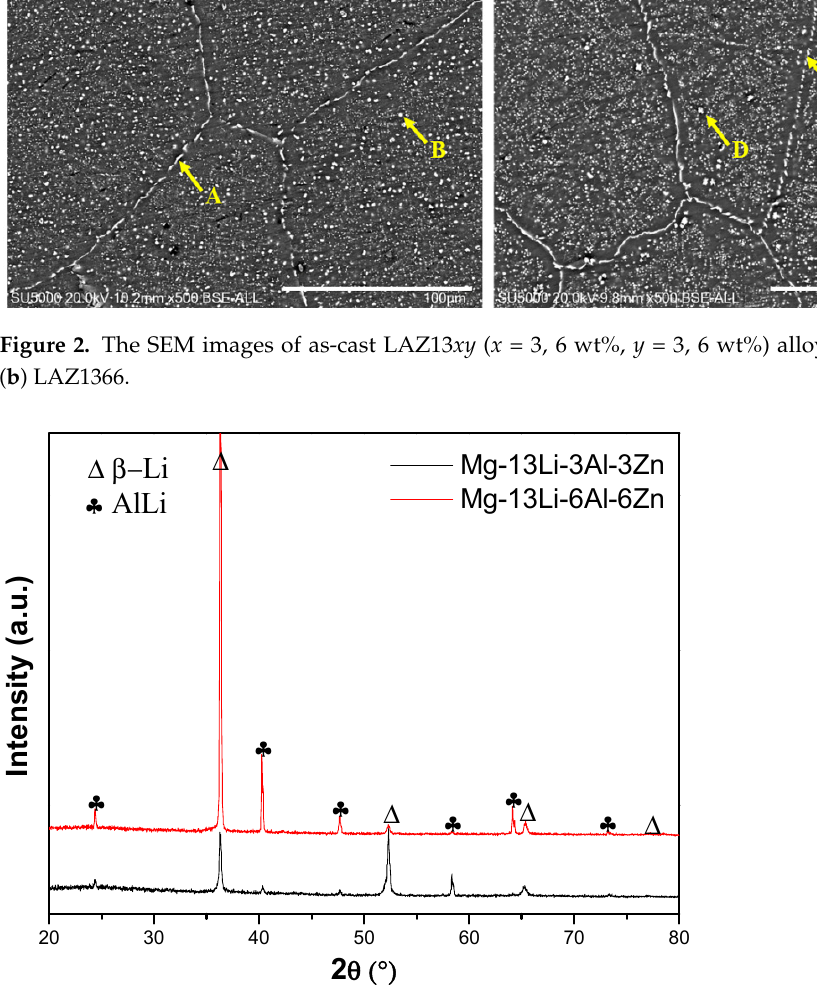
Figure 2. The SEM images of as-cast LAZ13 xy ( x = 3, 6 wt%, y = 3, 6 wt%) alloys: ( a ) LAZ1333, ( b ) LAZ1366. Table 1. The EDS results of the second phases marked by the yellow arrows and letters in Figure 2.